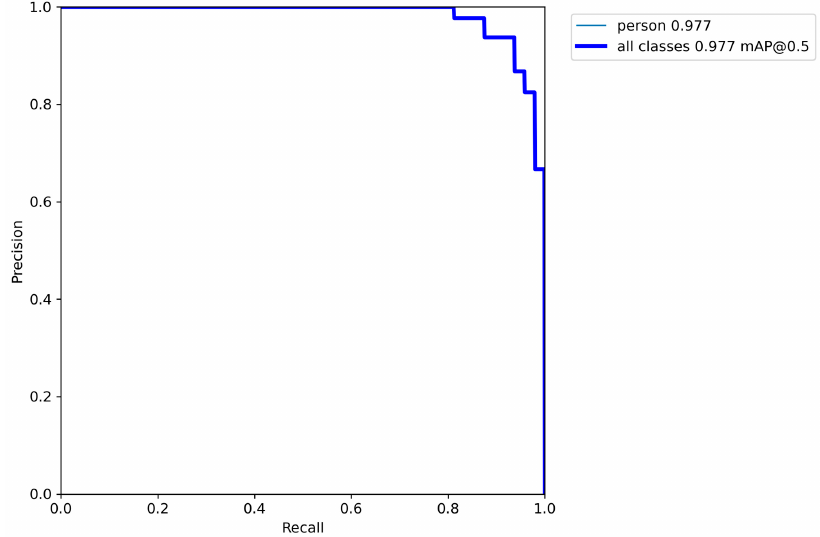
Figure 18. Detection result displayed after the enhanced model.